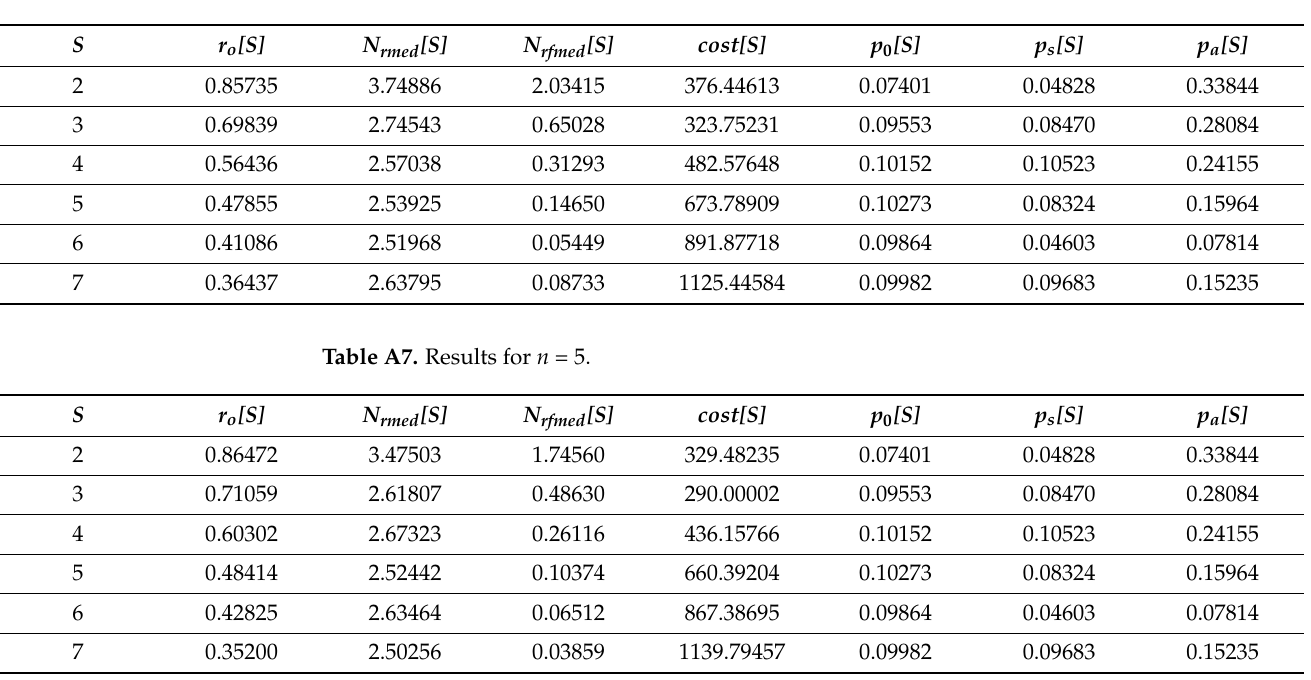
Table A6. Results for n = 3.